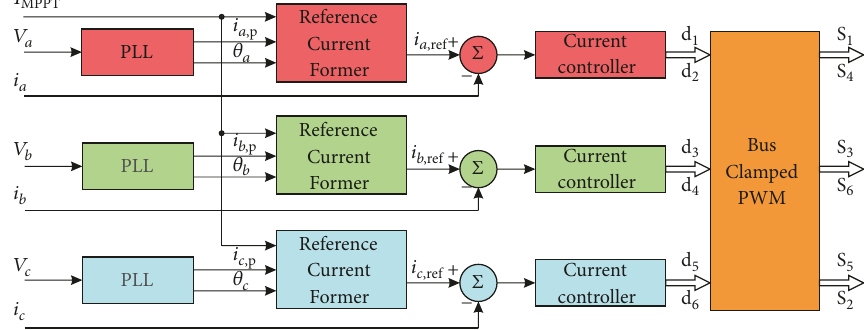
Figure 3: Block diagram of the control block of the BCPWM